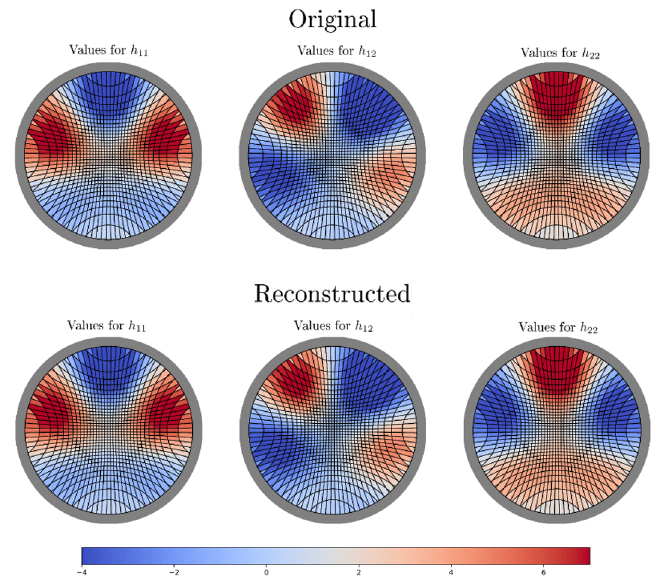
Figure 17. Top: Original bulk data generated with h 0 ( x, y ) = 2 e − ( x 2 + y 2 ) and h | C ( θ ) = cos(2 θ ) + sin(3 θ ) . Bottom: The bulk data reconstructed after running the forward Radon transform to get boundary data. Visually, the two sets of data are identical. The relative error between the two are E bulk ≈ 0 . 0273 (relative error 0 . 005516 without boundary tiles).